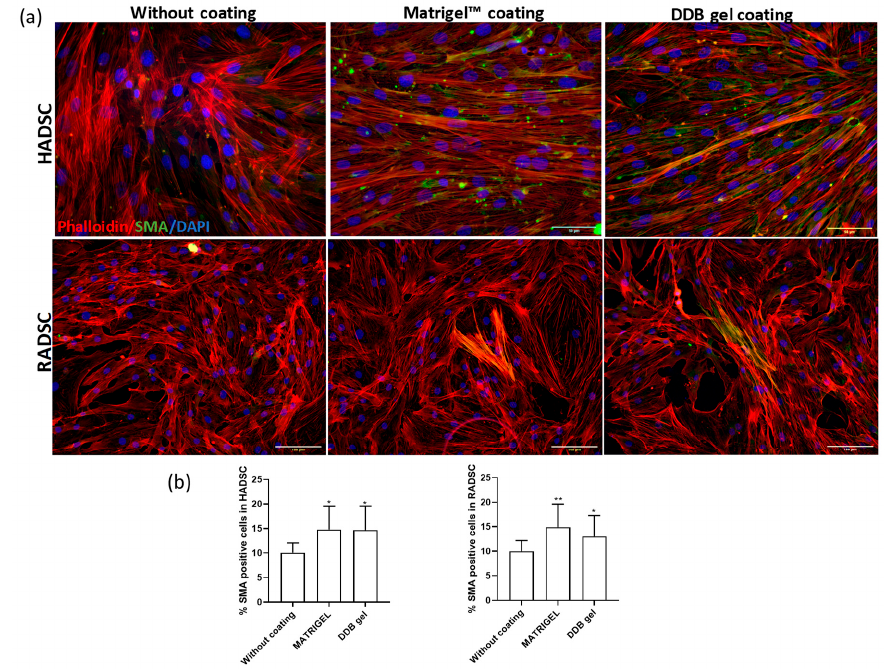
Figure 7. Smooth muscle actin (SMA) immune detection in rabbit ADSC (RADSC) and human ADSC (HADSC). ( a ) Cells grown on coverslips without coating or coated with Matrigel or DDB gel for one week. SMA, smooth muscle marker (green); Phalloidin (red); Dapi (blue). ( b ) Histograms showing the percent of SMA positive cells/DAPI positive cells for the tested substrates; * p > 0.05; ** p > 0.01.